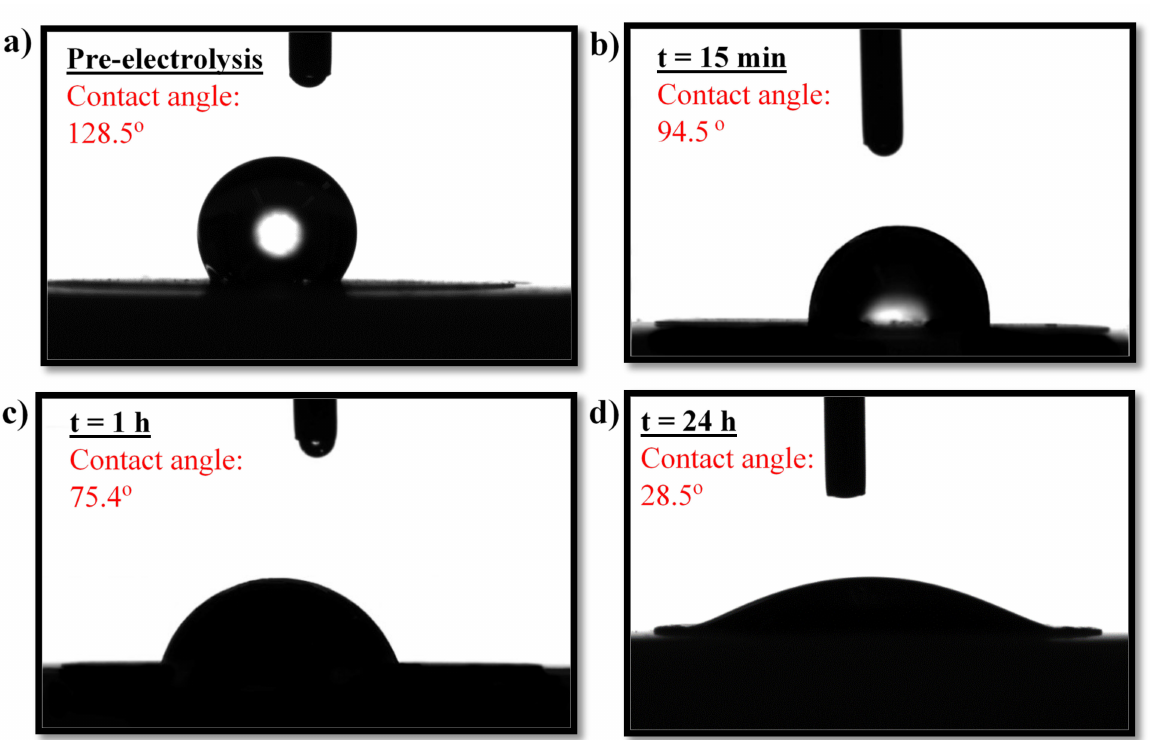
Figure 7. The wettability of the NiMoO4/CB/Nafion electrocatalyst layer (same specifications as Table 5 in Part I). Measured by the contact angle method for different electrolysis